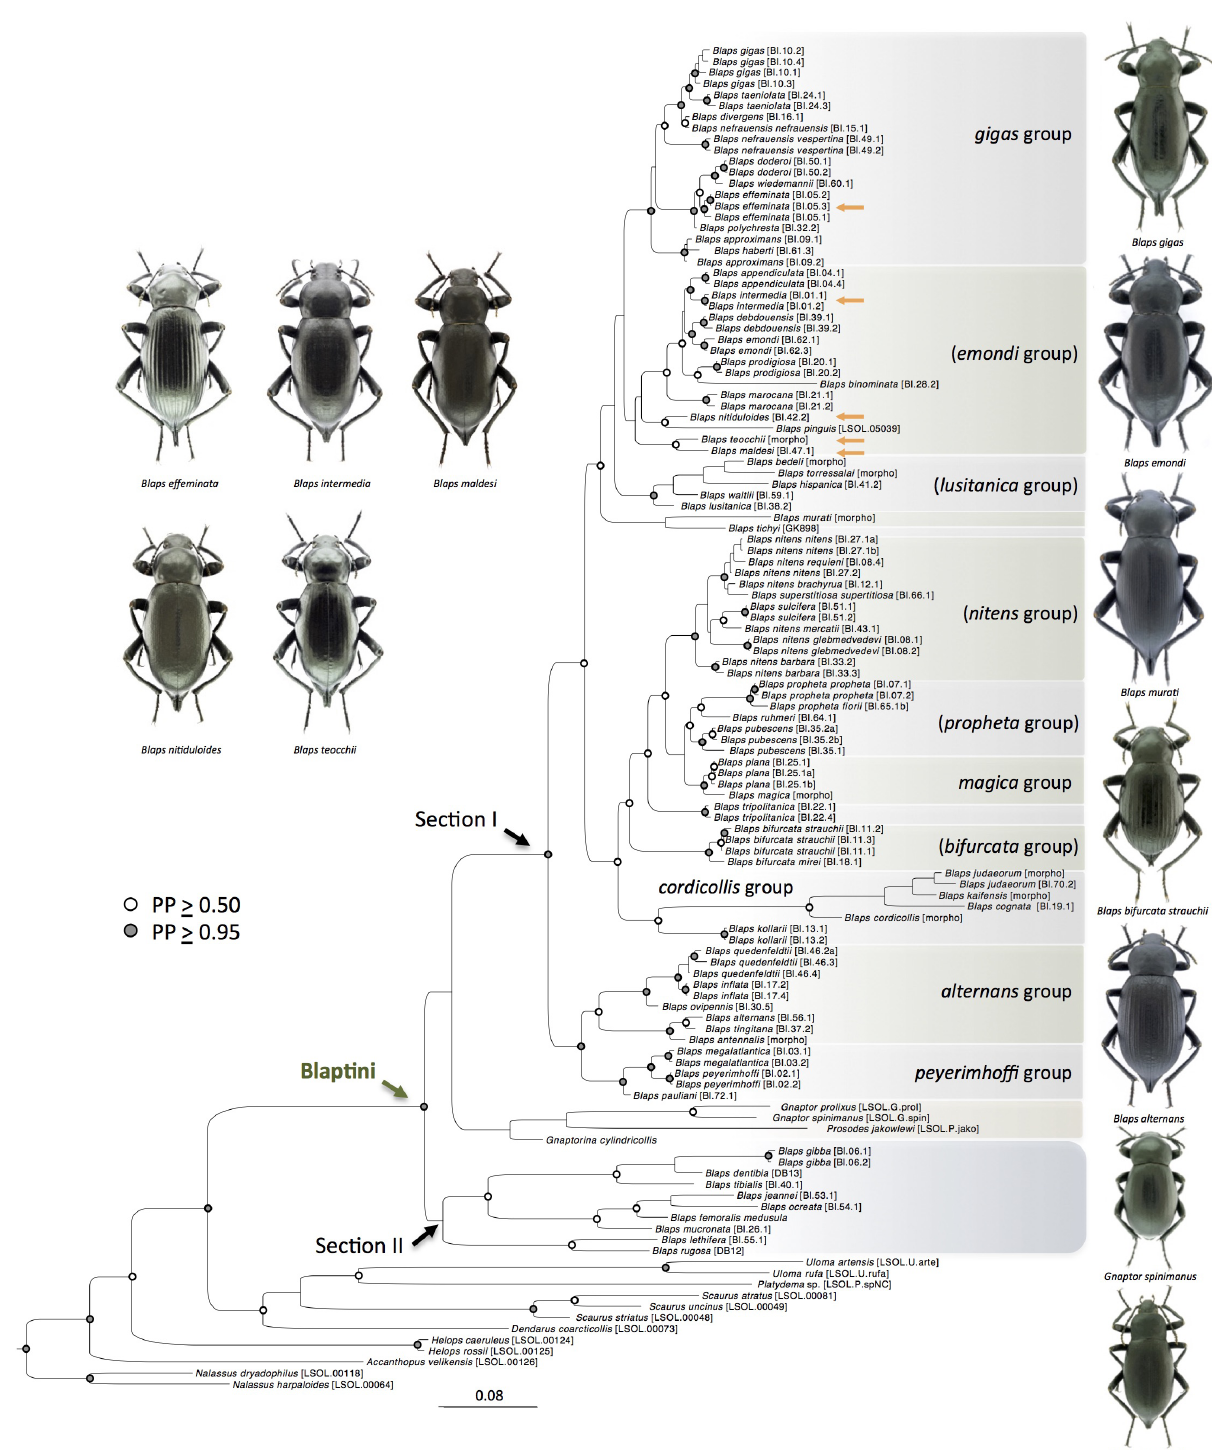
Fig. 6. Bayesian maximum consensus tree resulting from the analysis of the combined molecular and morphological dataset carried out with MrBayes. Support of nodes is indicated using empty circles (for PP > 0.50) and filled circles for PP > 0.95). Species groups for Blaps belonging to section I are highlighted using transparent coloured frames. Paraphyletic species groups are highlighted using bracketed names; orange arrows are also used to highlight the placement of the five new species. For illustrative purposes, the habitus of some adults are figured on the right side of the figure; on the left upper side, the habitus of the five new species are also presented (all photographs were taken by L.